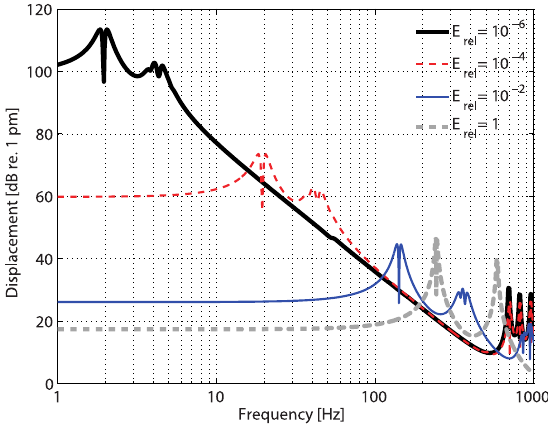
Fig. 7. The vibro-acoustic response, integral of the total displacement of Substructure 3 for four different Young’s module of the soft con- nectors, presented as the relative Young’s modulus.